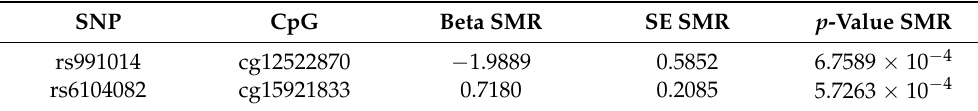
Table 4. Results of the summary data-based Mendelian randomization. SNP CpG Beta SMR SE